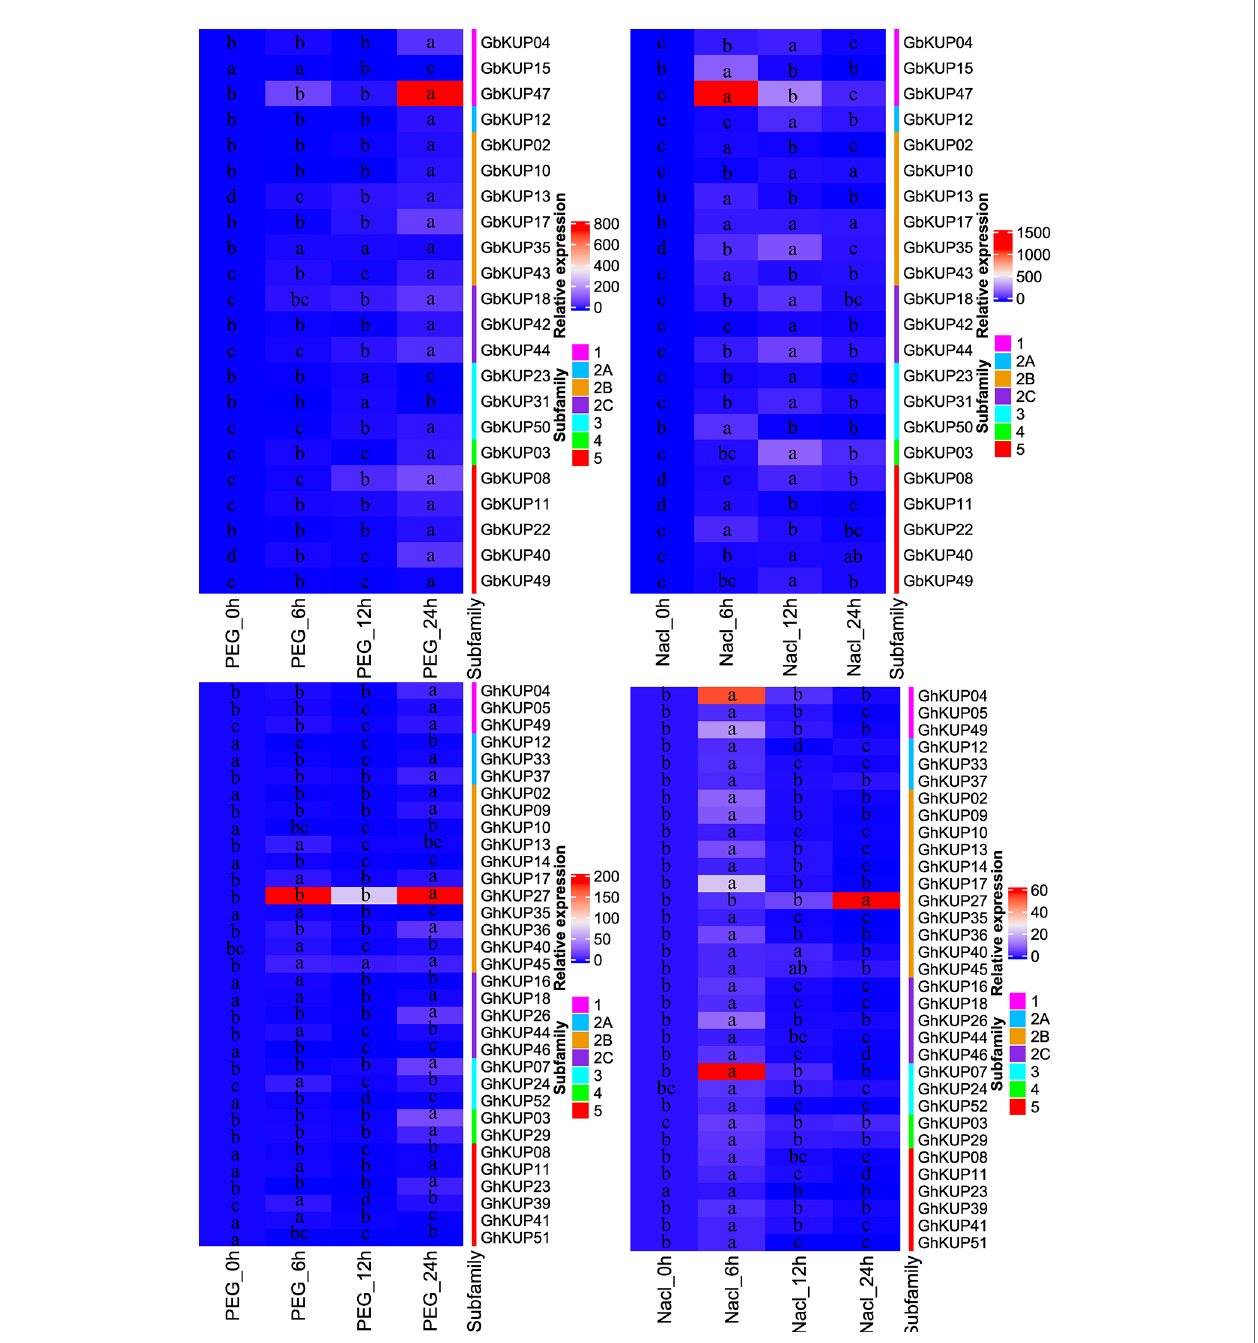
FIGURE 7 | Heat map representation of GhKUP and GbKUP expression levels under drought and salt stresses. Two color bars represent the relative expression value and KUP subfamily. Expression levels with the same letter in each cell do not signi fi cantly differ at P < 0.05 as revealed by Duncan ’ s multiple